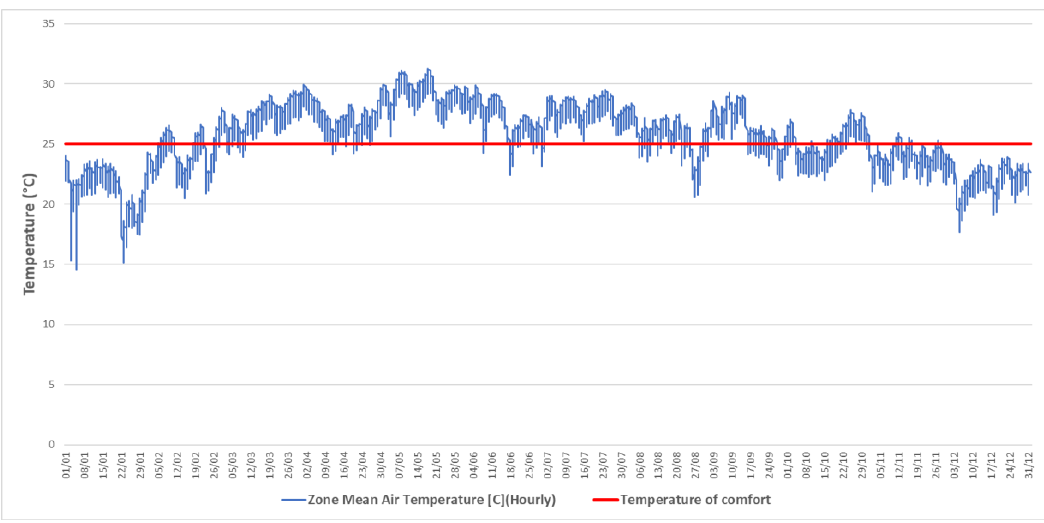
Figure 14. Annual indoor temperatures considering an urban absorption of 0.35.